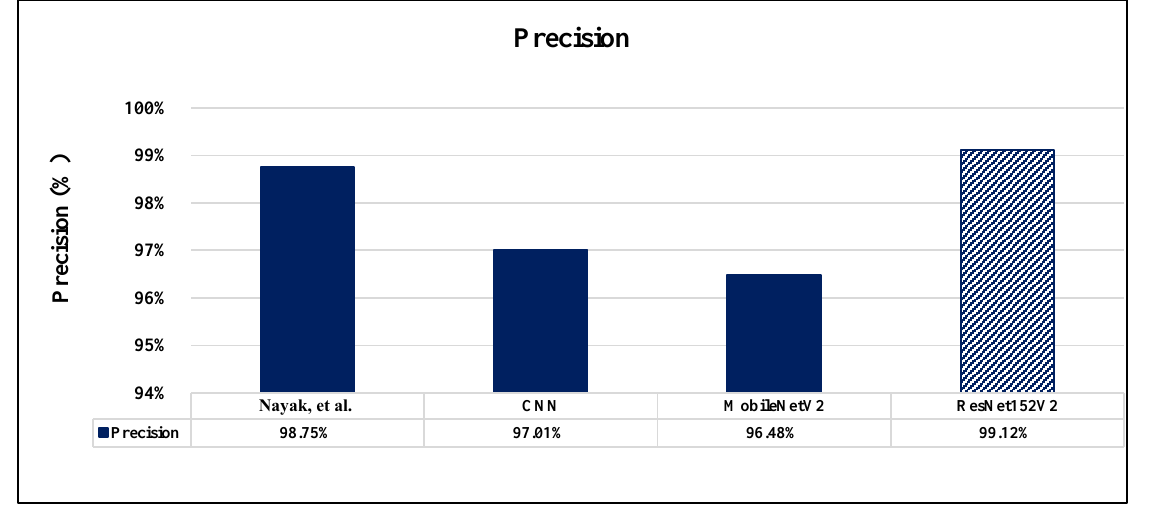
Figure 17. Precision performance metrics comparison between our proposed models and previous studies [18].